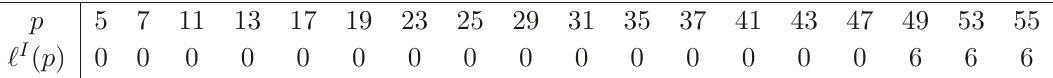
Table 2 . Number of zeros in the modular Wronskian for Hecke images under T p of Ising characters for small values of p